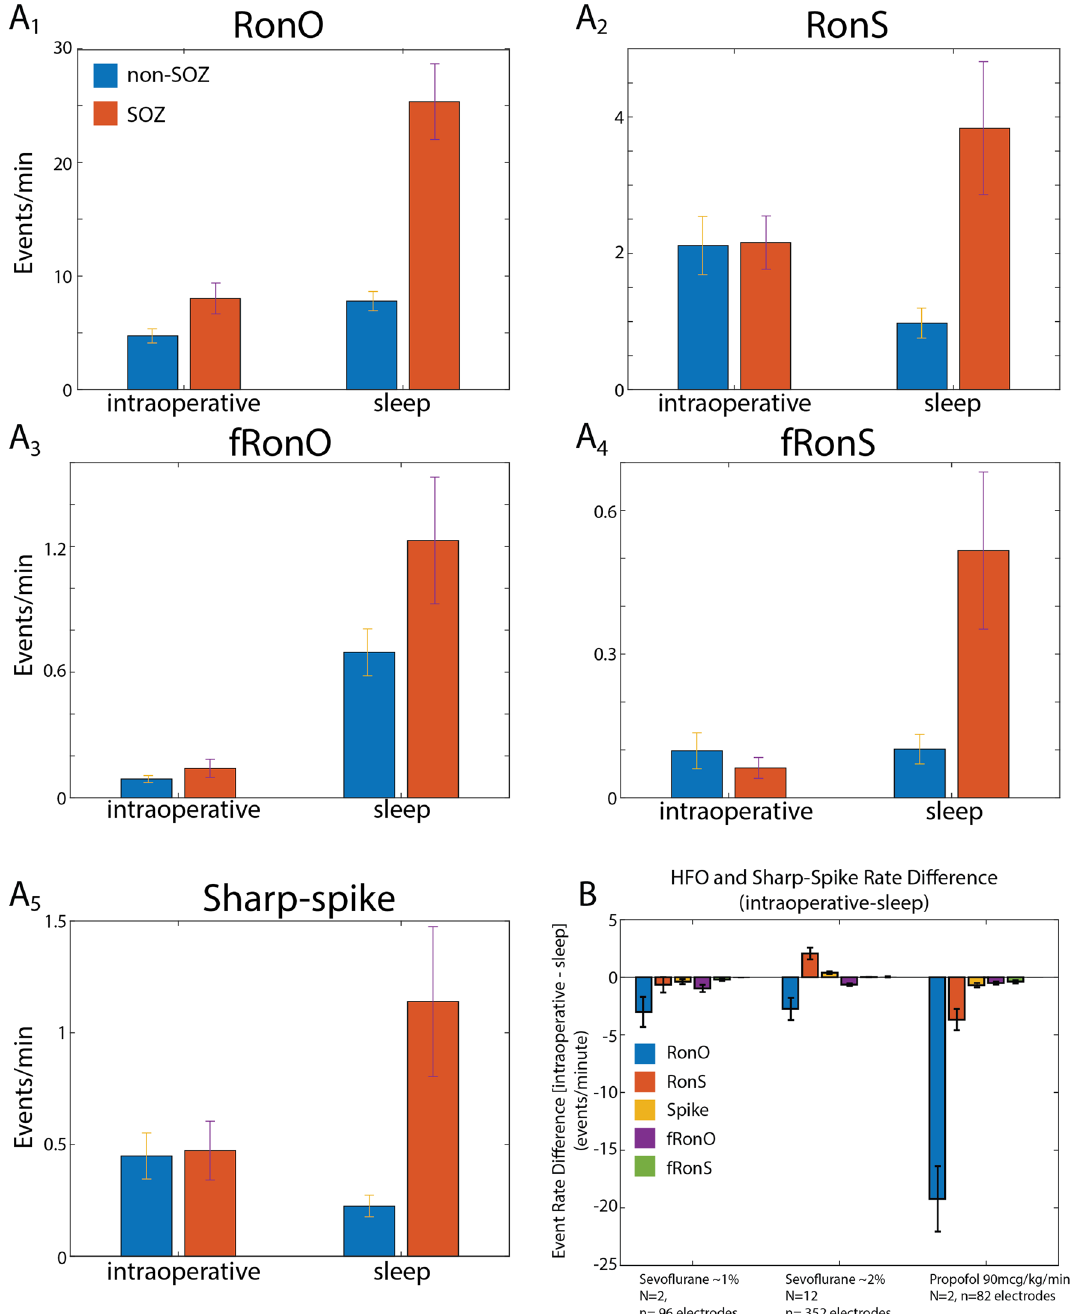
Figure 2. Mean HFO and spike rates in relation to the SOZ, recording condition, and anesthesia. ( A1–5 ) A comparison of mean event rates in the non-SOZ (blue) and SOZ (orange) in the intraoperative (left) and sleep (right) condition measured from matched electrode contacts. The rate of RonO (A1), fRonO ( A3 ), and fRonS ( A4 ) was higher during sleep than intraoperative recording (rmANOVA, p < 0.05, N = 16 patients, d.f. = 523,1,1,2 contacts). For both conditions combined, the rate was higher in the SOZ than the non-SOZ for all the individual biomarkers ( p < 0.01). However, the difference in the rate of HFOs between SOZ and NSOZ was larger during sleep than intraoperative recordings ( A1–5 , p < 0.05). ( B ) Differences in HFO and spike rates (intraoperative minus sleep) for each matched electrode contact with respect to anesthesia type and dose. In most cases, rates of HFO were lower during anesthesia than sleep, indicated by negative values in bar chart. Note RonS and spikes were higher during 2% sevoflurane than non-REM sleep. Error bars indicate standard error of the mean